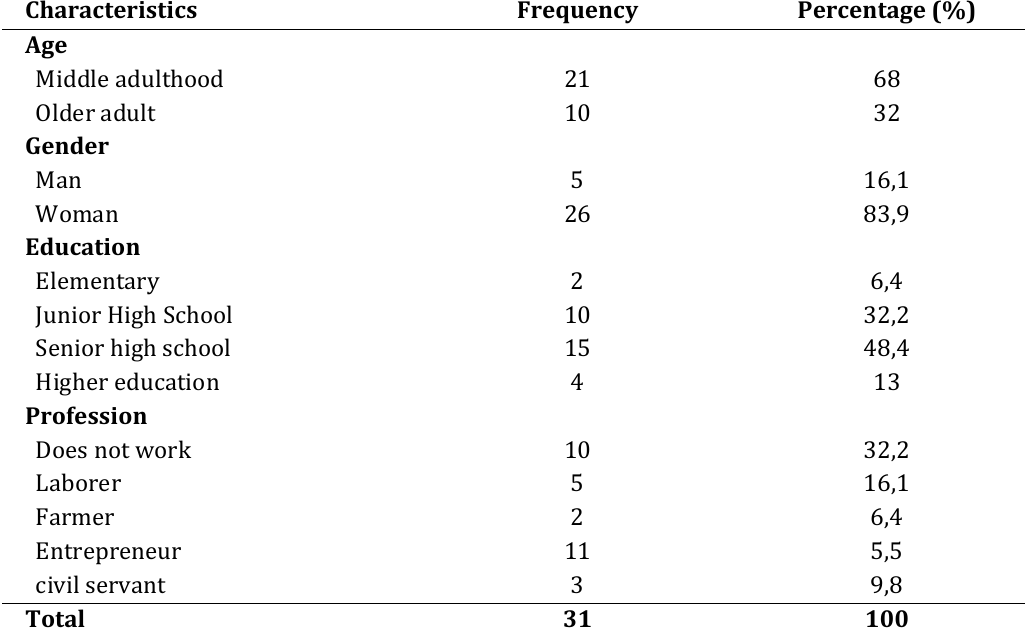
Characteristics of respondents (n=31)